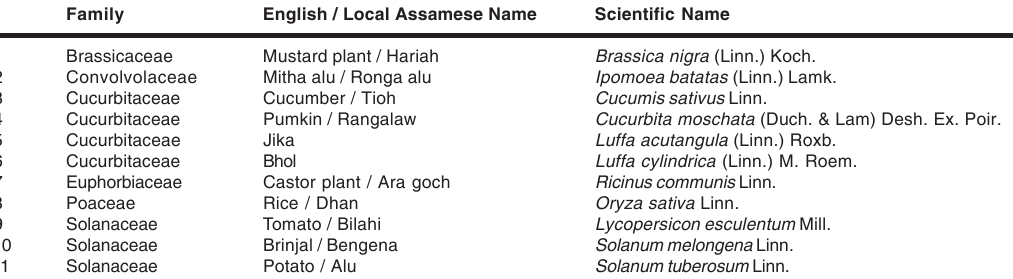
Table 2. List of cultivated food plant species consumed by rhinos in Pobitora Wildlife